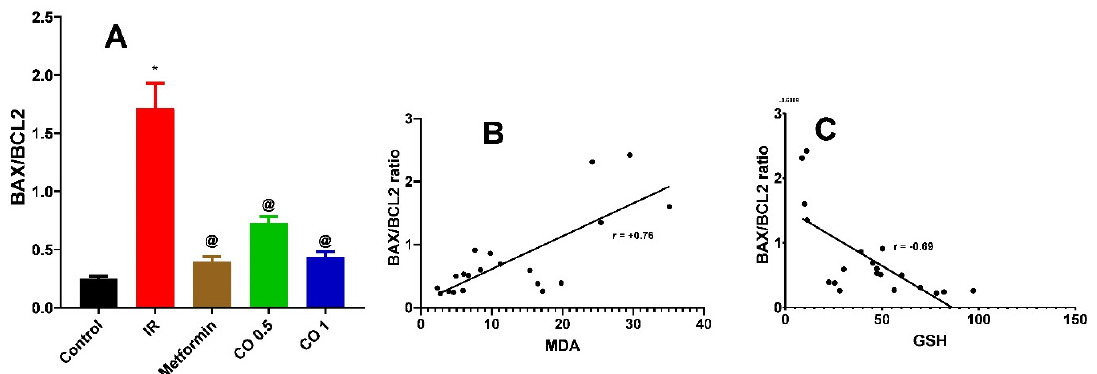
Figure 9. Effect of coriander oil (CO, 0.5 and 1 mL/kg, PO) and metformin (50 mg/kg/day, PO) on BAX/BCL2 ratio ( A ) in dexamethasone-induced insulin resistance in rats (IR). Results were analyzed by one-way ANOVA followed by the Post-hoc Tukey test. Results are shown in mean ± SEM ( n = 6). * , @ p < 0.05 compared to normal, and IR groups, respectively. ( B ) Correlation analysis between MDA and BAX/BCL2 ratio. ( C ) Correlation analysis between GSH and BAX/BCL2